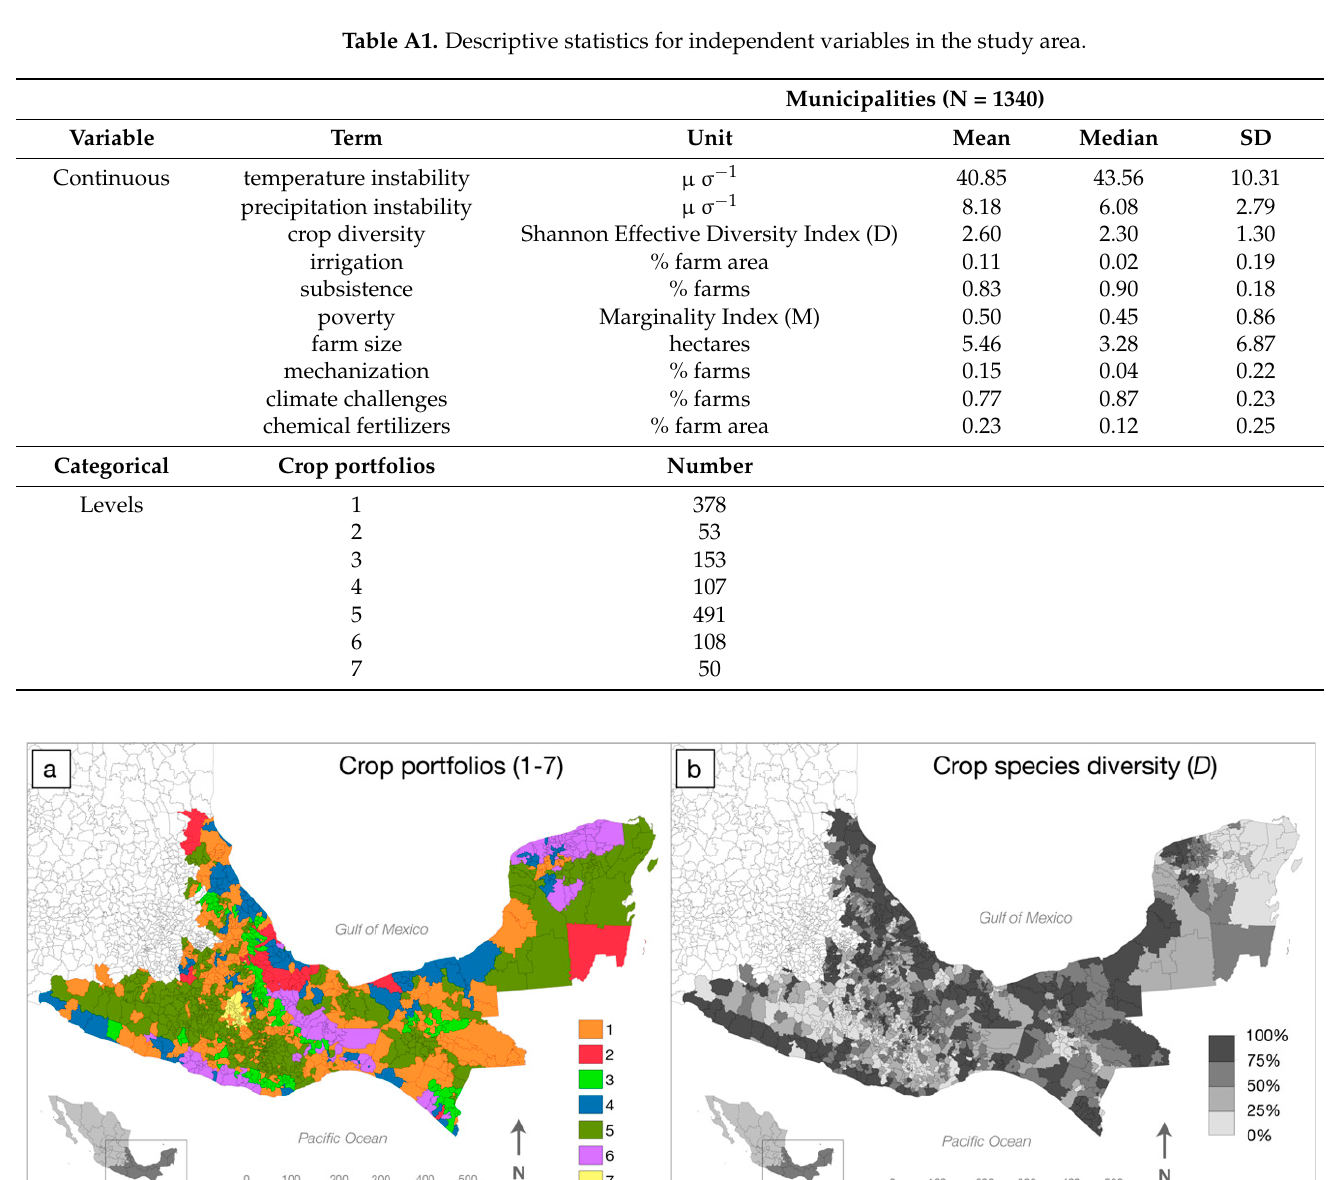
Figure A2. Municipalities in the study area by ( a ) crop portfolio designation and ( b ) relative crop species diversity (Shannon Effective Diversity) quartiles.